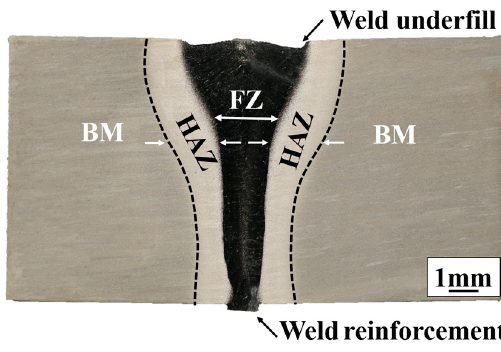
Figure 2. Macrostructure of electron beam welding (EBW) joint of TC17 titanium alloy.